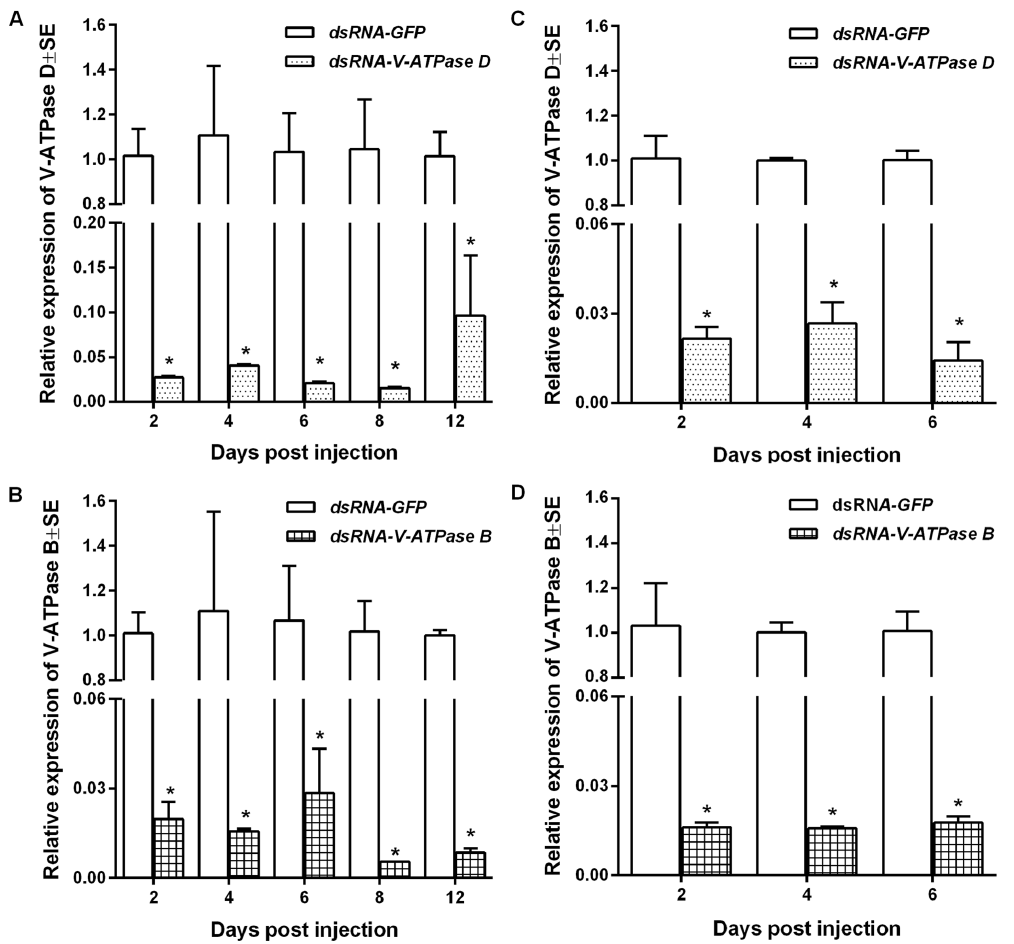
Figure 2. Reduction in the normalized abundance of V-ATPaseB and D transcripts in Peregrinusmaidis by injection of dsRNA. ( A and B ) 5 th -stage nymphs or ( C and D ) young adults of P. maidis were injected with 50 nL of dsRNA (250 ng) of V-ATPase D , V-ATPase B , or GFP as a negative control and harvested every two days for real-time quantitative reverse transcriptase-PCR analysis of gene knockdown. The abundance of ATPase B and V-ATPase D transcripts was normalized to P. maidis ribosomal L10 transcripts. Each bar represents the mean and standard error of the mean of n = three experimental replicates each consisting of a group of three insects. The asterisk (*) indicates that treatment means differ significantly ( P , 0.05) at a given time-point.